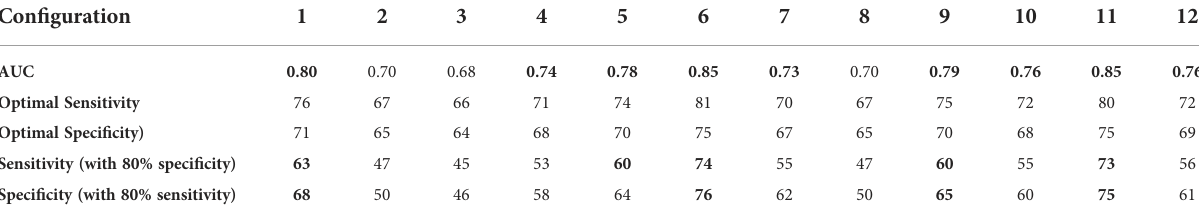
The bold values show con fi gurations, which meet the diagnostic criteria. TABLE 4 Assessing frequency composition method against diagnostic criteria in Table 2 . Criteria Yes/No Values Unbiased diagnostic Yes Full automation Yes Ability to diagnose tumors down to 7mm Yes Robust to varying breast sizes and